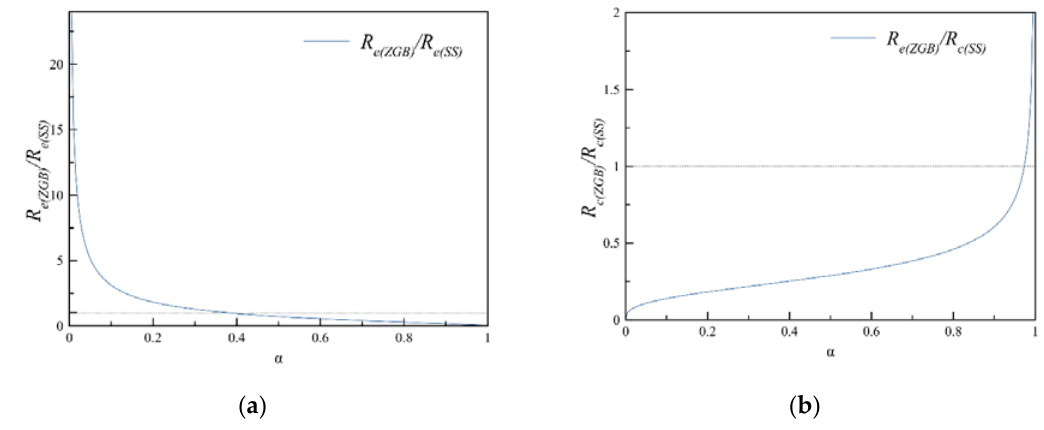
Figure 11. Comparison of the evaporation and condensation rates of SS and ZGB models; ( a ) Figure11. ComparisonoftheevaporationandcondensationratesofSSandZGBmodels; ( a )evaporation, evaporation, ( b ) condensation. ( b )